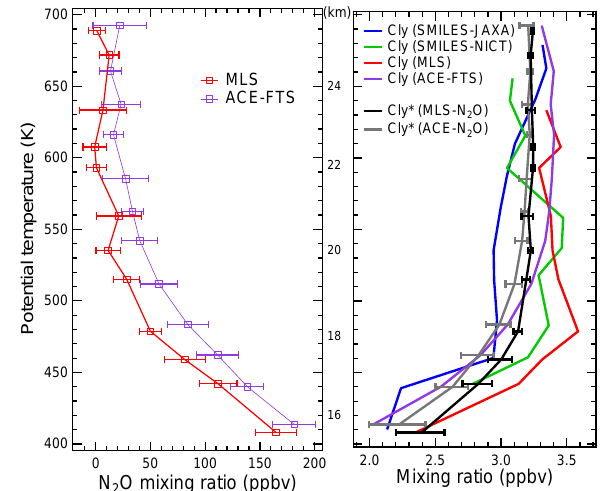
Fig. A1. Vertical profiles of N 2 O measured by MLS (red) and ACE- FTS (purple) on 19–24 November 2009 inside the Antarctic vortex (within the edge center) as a function of potential temperature, PT (left panel). The average and ± 1 σ standard deviation in each 25K PT bin are shown. Approximate altitudes corresponding to PT are shown on the right-hand side of the panel. Composite Cl y values calculated from SMILES, MLS, and ACE-FTS (see Sect. 4.3) and the Cl y ∗ values deduced from the N 2 O values from MLS and ACE- FTS (see Appendix A) are shown in the right panel. Bars show cor- responding Cl y ∗ values estimated from the standard deviations of N 2 O